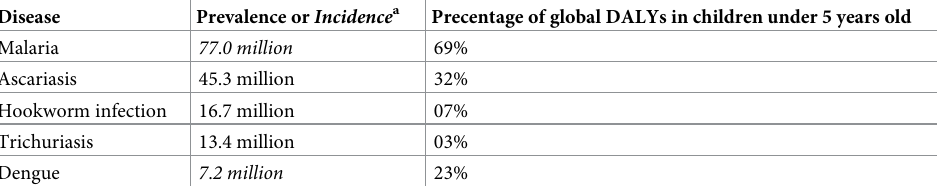
Table 1. Prevalence or incidence of tropical infections in children under 5 years old (information from [1–4]).